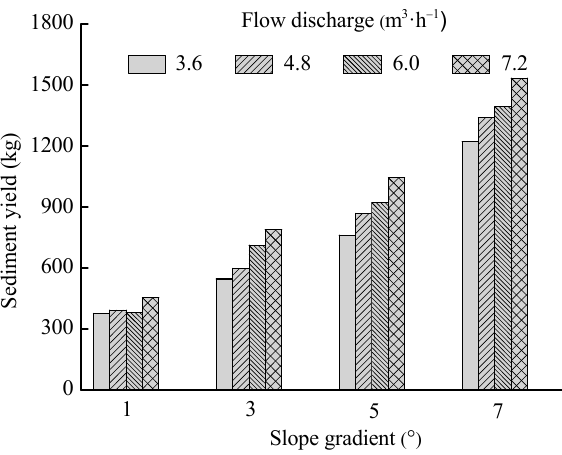
Figure 9. Sediment yield under different slope gradients and flow discharges.